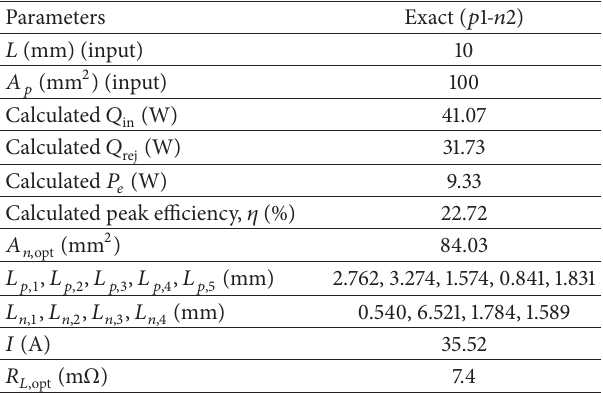
Table 4: Design and performance characteristics of 𝑝 1- 𝑛 2 generator at maximum output power, calculated through exact method.